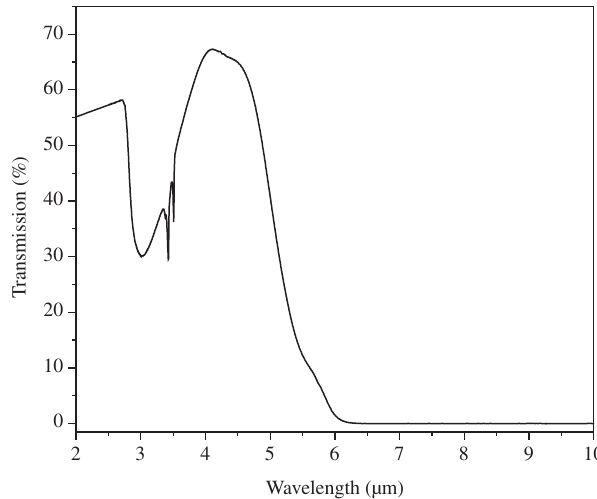
Figure 1. Infrared transmission spectrum of the GP glass with 2 mm thick- ness.